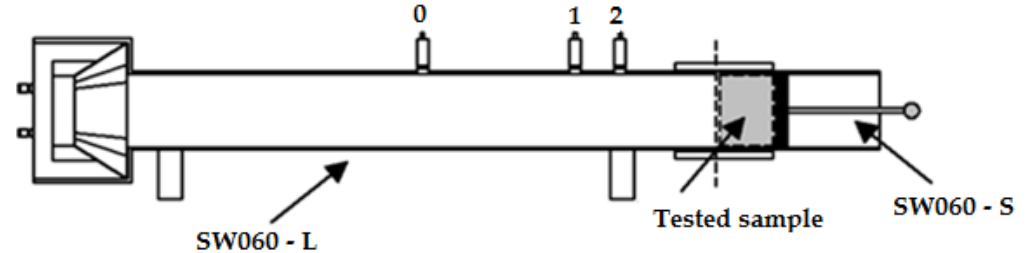
Figure 2. The sound absorption coefficient ( α ) system measured: 0, 1, and 2 are the mounting places for microphone sockets.